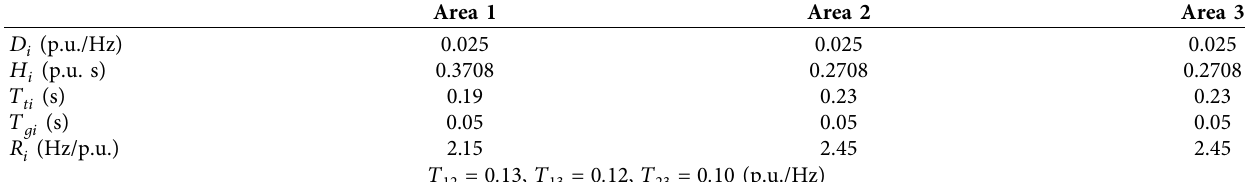
( t ) and (b) Δ P ( t ) of each power grid under load disturbance and sensor fault. i tie,i Table 1: The parameters of the three-area power grid. Area 1